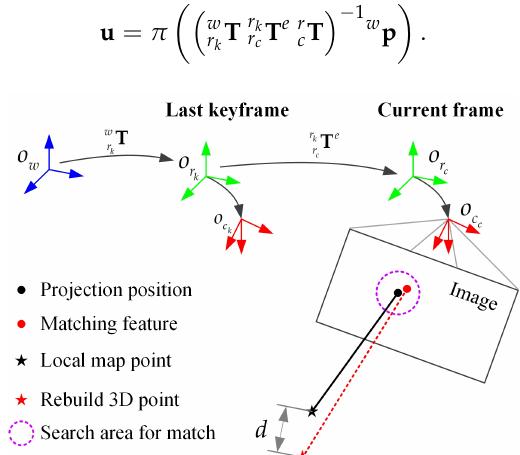
Figure 3. Principle of matching of the local map points with the ORB